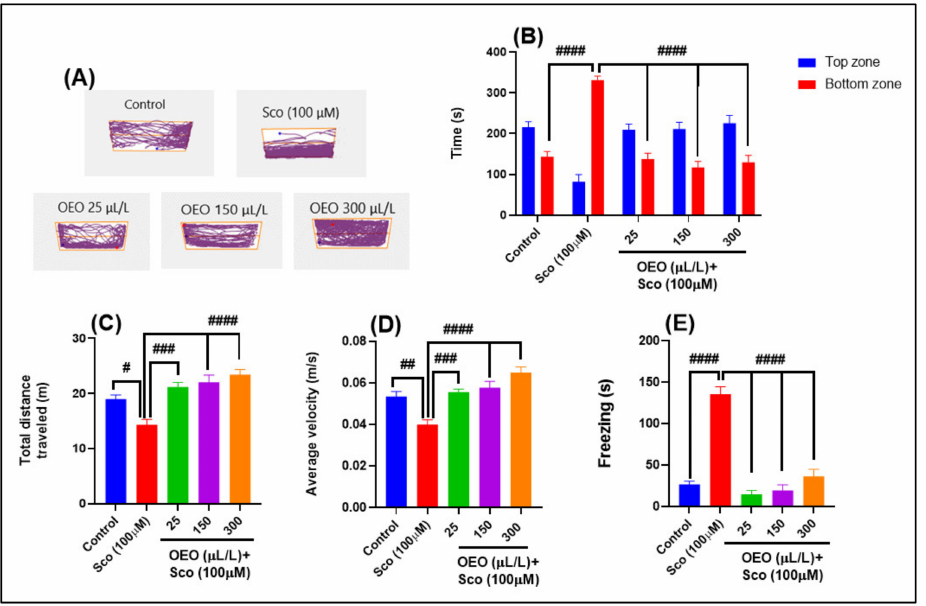
Figure 2. Origanum vulgare ssp. hirtum essential oil (OEO: 25, 150, and 300 µ L/L) improved locomo- tion pattern and reduced anxiety in the NTT test: ( A ). Locomotion tracking patterns of the control, scopolamine (Sco: 100 µ M), and OEO (25, 150, and 300 µ L/L) treated groups; ( B ). The time spent in the top/bottom zone by zebrafish in the tank in different groups; ( C ). The total distance traveled (m) by zebrafish in different groups; ( D ). The average velocity (m/s) of zebrafish in the tank in different groups; ( E ). The freezing duration (s) of zebrafish in the tank in different groups. Values are means ± S.E.M. ( n = 10). For Tukey’s post hoc analyses: # p < 0.01, ## p < 0.001, ### p < 0.0001, and #### p <